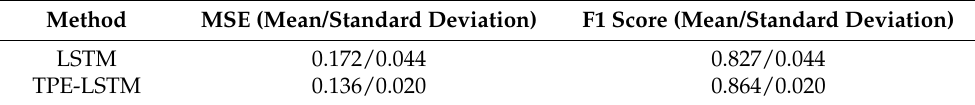
Table 4. The classification performance: LSTM selected for improvement versus TPE-LSTM. Cleve- land dataset.